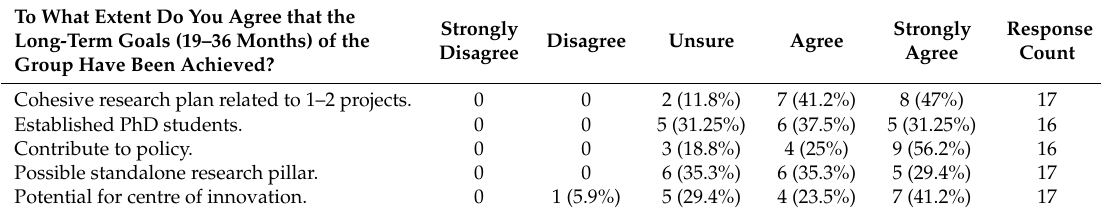
Table 4. The extent to which SIG members agree that the long-term goals (19–36 months) of the group have been achieved.